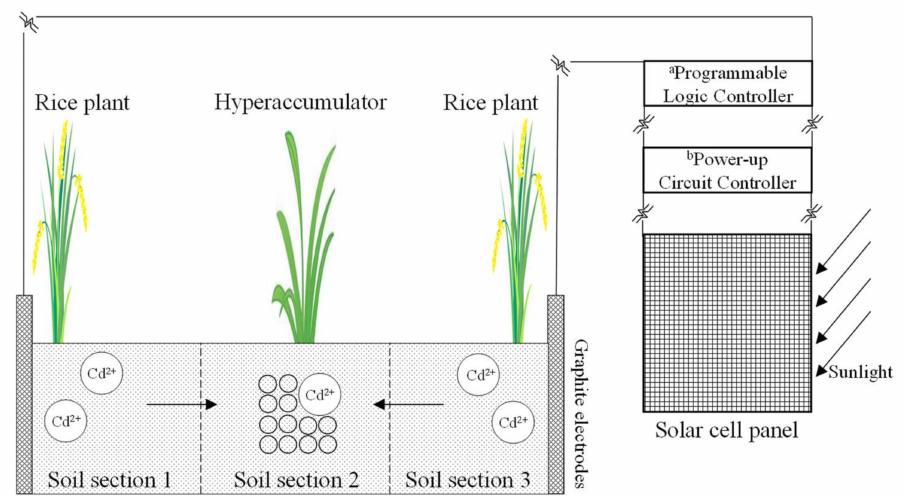
Figure 7. The electrokinetic-assisted phytoremediation technology of Cd-contaminated soil remedia- tion during rice production process. a Programmable logic controller: with the functions of timing control and action sequence control, it can be programmed to automatically control pulsed electric fields and polarity exchanging operation. b Power-up circuit controller: boosting the output voltage of solar cell to meet the needs of field